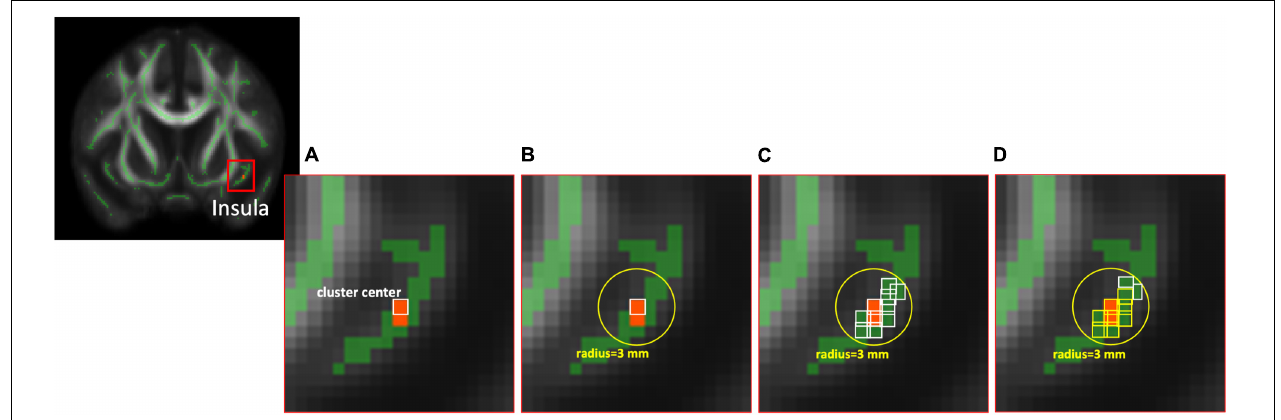
FIGURE 1 | The diagram of ROI selection. (A) The cluster center was derived from the statistical analysis between two groups based on voxel-wise TBSS with significant differences. (B) The spherical ROIs with radius = 3 mm were estimated using the MarsBaR toolbox. (C) The voxels (white bounding) within the FA skeleton based on TBSS were reserved first, then (D) the voxels (yellow bounding), which are the same anatomical region of AAL as the cluster center, were selected at last for further ROI-based analysis. ROI, region of interest; TBSS, tract-based spatial statistics; FA, fractional anisotropy; AAL, automated anatomical